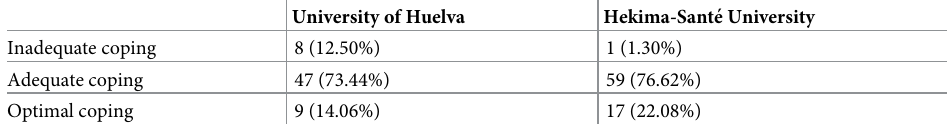
Table 2. Distribution of scores pertaining to Bugen’s Coping with Death Scale.